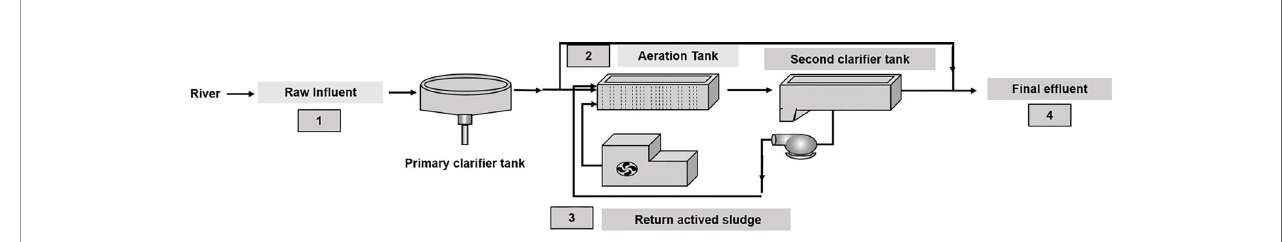
FIGURE 1 | The fi gure shows the four sampling points of the wastewater treatment plant: raw in fl uent, aeration tank, return activated sludge, and fi nal ef